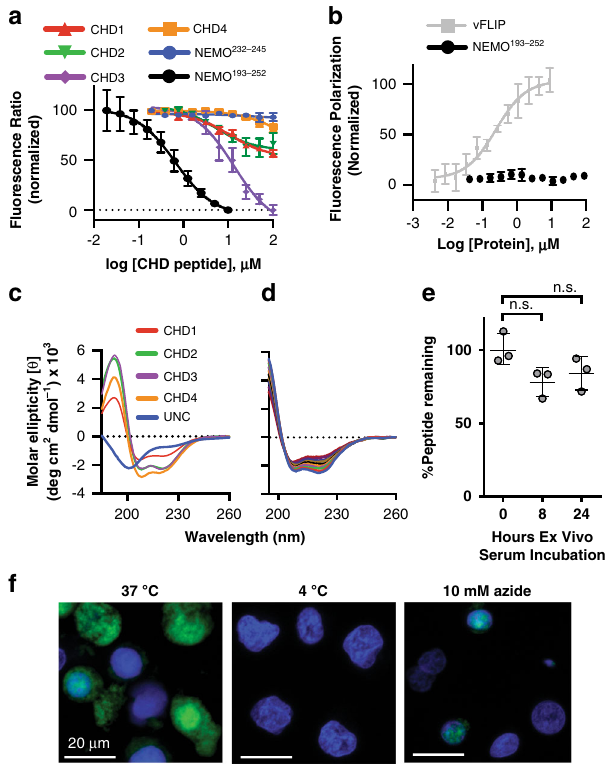
Fig. 3 Biophysical characterization, stability and cellular uptake of NEMO mimics. a The potential of NEMO mimics to inhibit vFLIP- NEMO interaction was evaluated in a TR-FRET assay by monitoring the fl uorescence emission of the acceptor. The data represents the mean ± SD of two independent experiments ( n = 2) each performed with at least three replicates. These studies illustrated the potency of the optimized derivative CHD3 NEMO . b The speci fi c association of the FITC- derivatized CHD3 NEMO with vFLIP over full length NEMO was further probed in a fl uorescence polarization assay. The data represents the mean ± SD of a single experiment performed in triplicates. This experiment was repeated twice ( n = 2) with similar results. c The conformation of the coiled coil mimics was investigated by circular dichroism spectroscopy in aqueous buffer. d The conformational stability of CHD3 NEMO was further evaluated in a thermal denaturation study. The circular dichroism spectra were collected at regular intervals between 5 – 95 °C. e CHD3 NEMO was found to resist serum proteases. Peptide degradation was probed over 24 h by HPLC. This data represents mean ± SD ( n = 2) f Cellular uptake of FITC-labeled CHD3 NEMO into live BC-1 cells. Cells were visualized by fl uorescence microscopy after 1 h incubation. Effect of temperature and 10 mM sodium azide on the cellular uptake of the NEMO mimic was also explored. Hoechst stain was used to detect the nuclei. Representative images are shown from 2 independent experiments ( n = 2). Scale bar = 20 μ